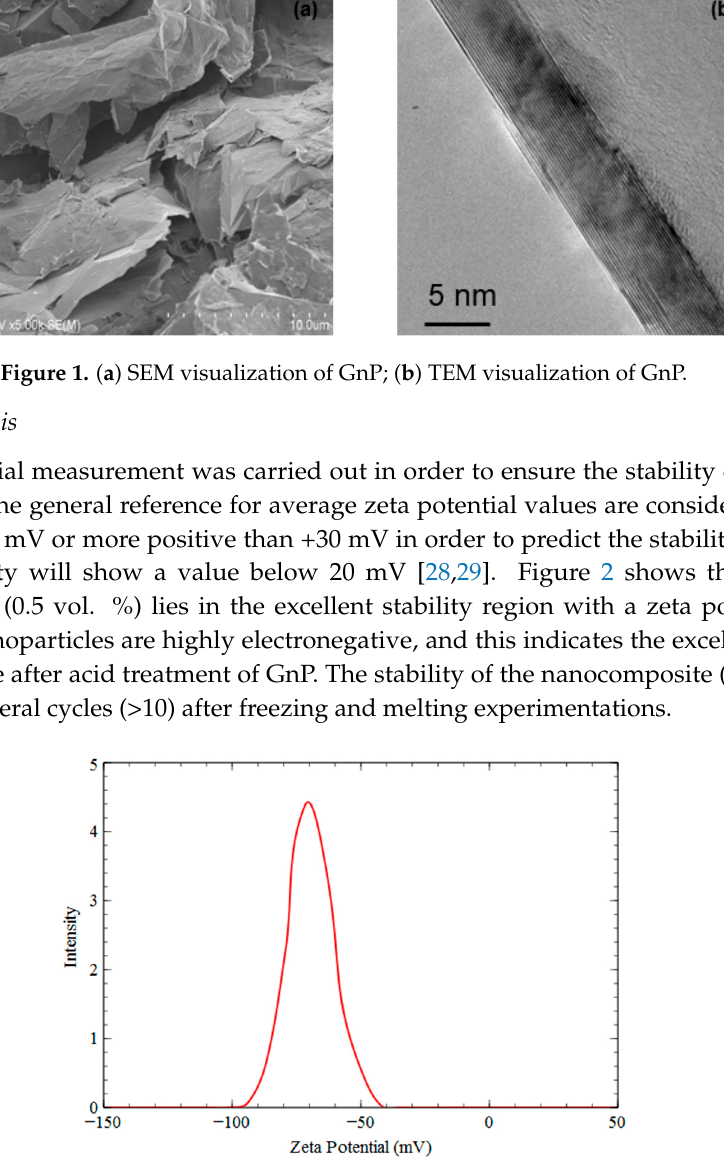
Figure 2. Zeta potential distribution of the nanocomposite at 0.5 vol. %.